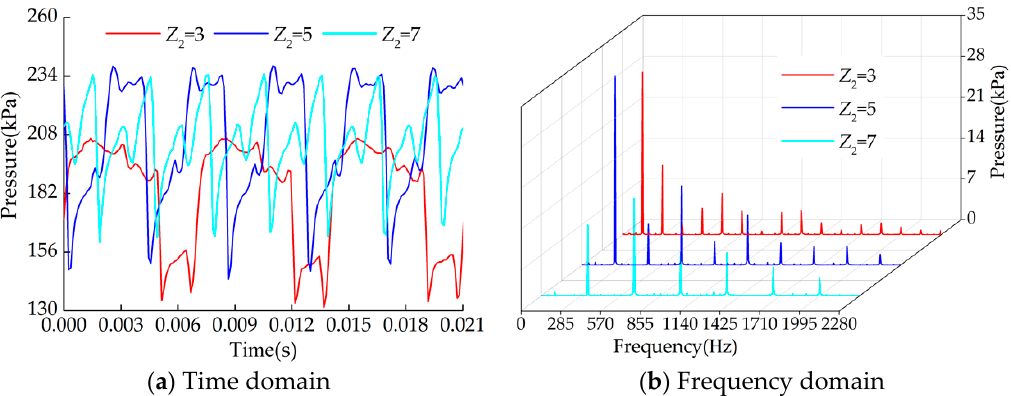
Figure 11. Time and frequency response curves of pressure inside the impeller with different numbers of guide vanes.